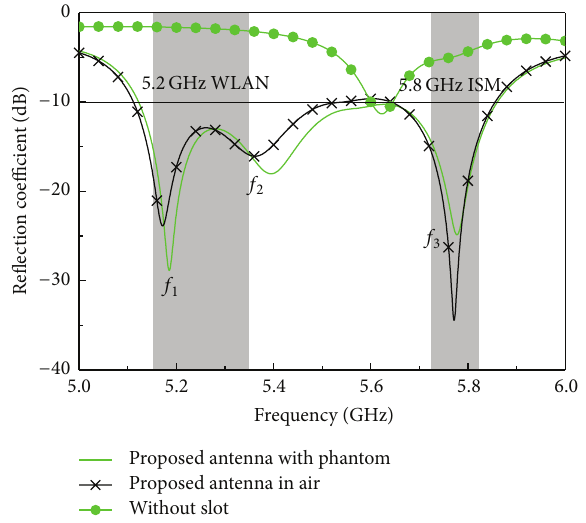
Figure 3: Simulated reflection coefficients of the proposed antenna in air and on the phantom and those of the antenna without a slot.